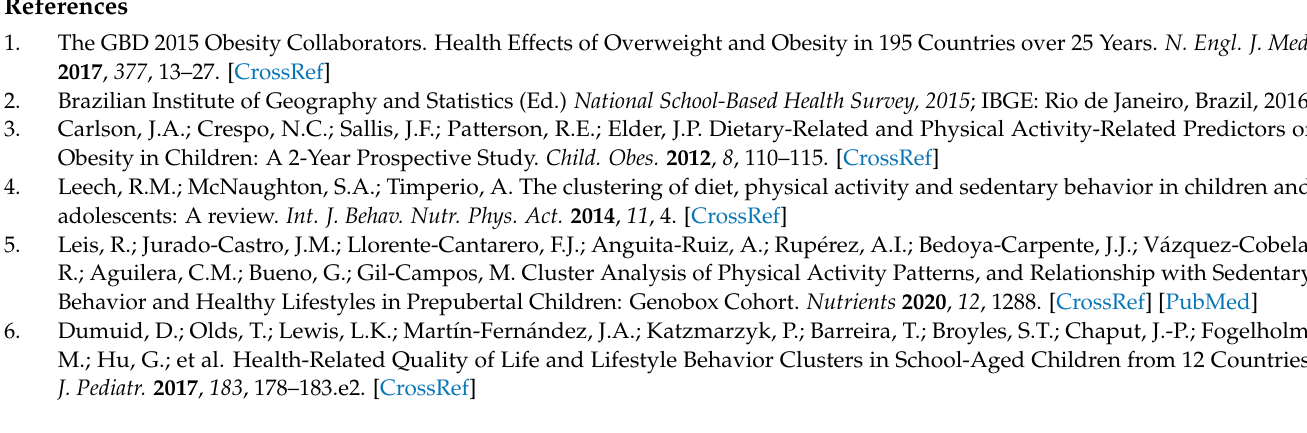
Table S3: Prevalence and item-response probabilities for the 2 latent class model of physical activity, diet and sedentary behavior of Brazilian